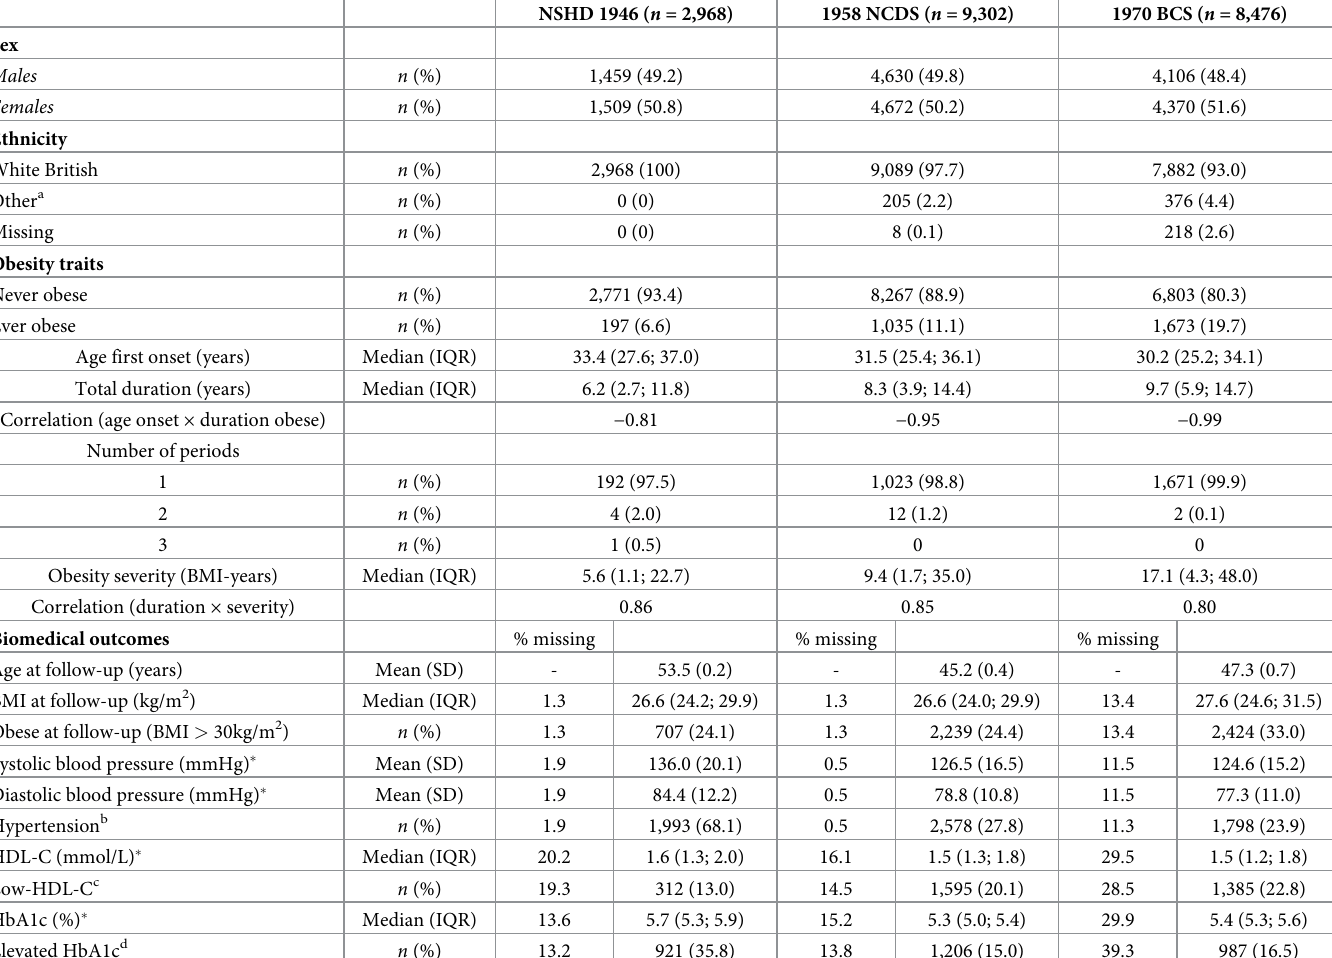
Table 1. Descriptive statistics for life course obesity parameters and cardiometabolic disease risk factors at the biomedical sweep of those in target study sample ( n =